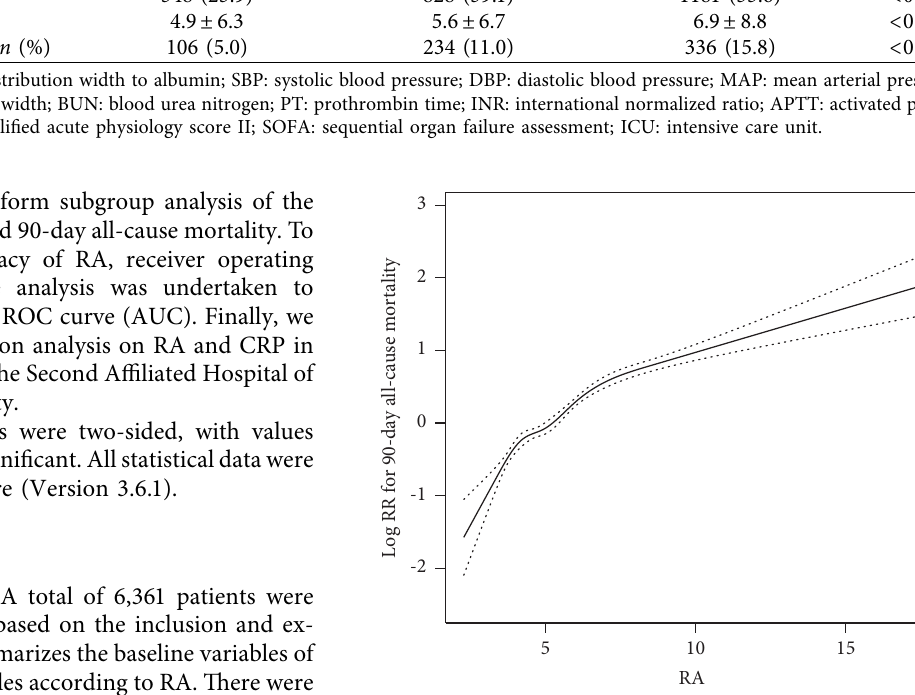
Figure 1: Association between RA and 90-day all-cause